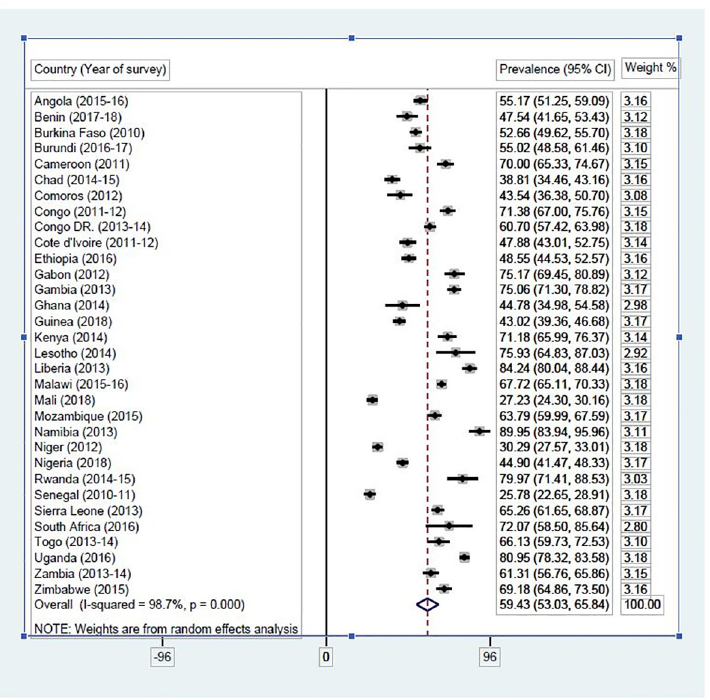
Fig 2. Proportion of female adolescents in SSA who can refuse to have sex with a partner. Source: Authors’ computations.